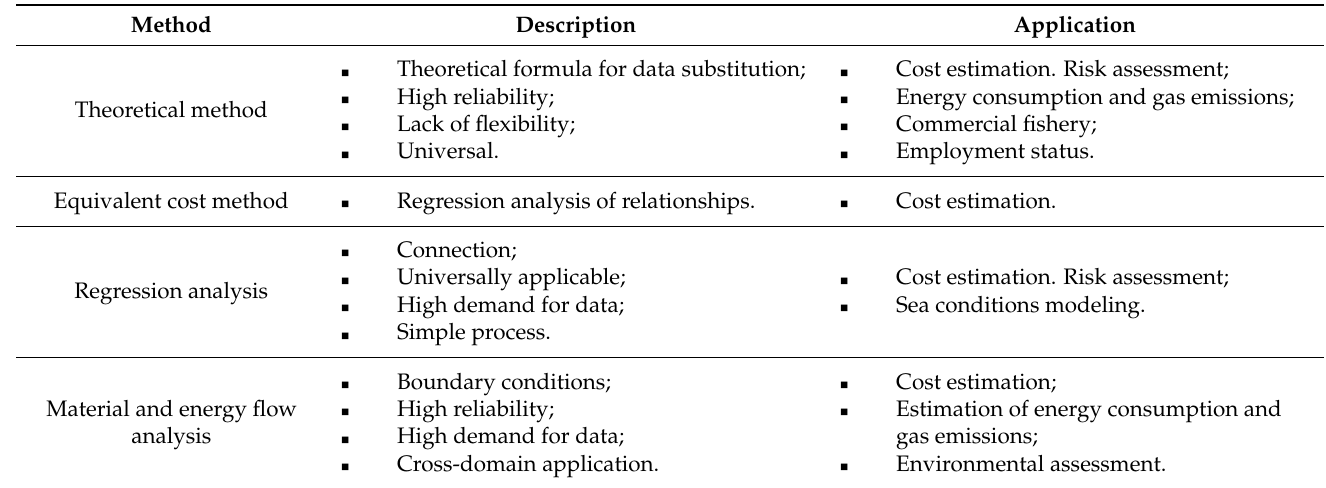
Table 1. Quantitative methods and their description.